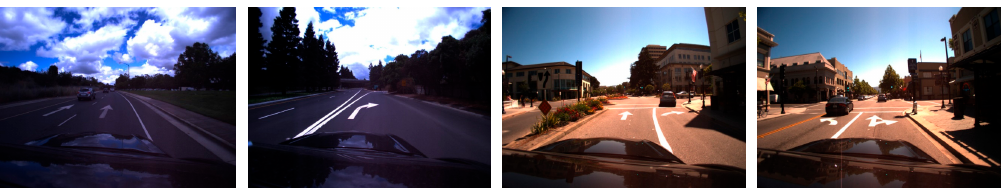
Figure 3. Example images from Road marking dataset.